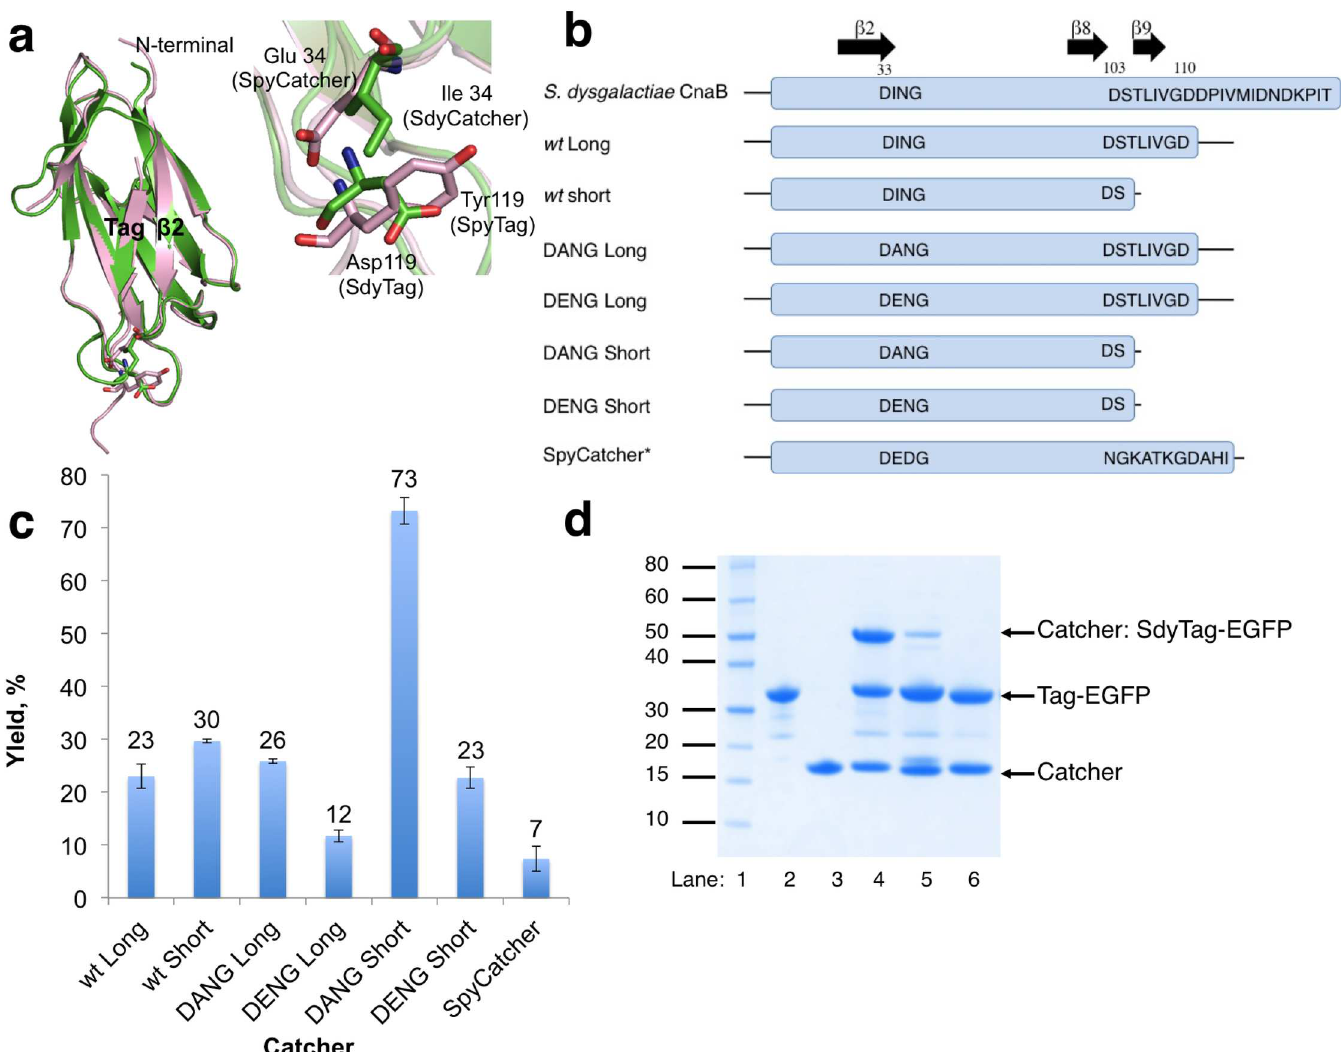
Fig 2. Optimization of S . dysgalactiae Catcher. (a) Alignment of I-TASSER homologymodel of S . dysgalactiae CnaB domain (green) and SpyTag- SpyCatcher complex (pink, 4MLI [24]). Depiction of structure was performed using PyMOL [25]. Inset depicts residues at position 119 (Tag) and 34 (Catcher) for SpyCatcher-SpyTag (pink) and SdyCatcher-SdyTag (green). (b) Schematic diagramof the Catcher variants. Amino acid sequences of the constructs can be found in S1 Table. Residueand beta sheet numbering as follows from Fig 1B. * SpyCatcher sequenceas follows from Zakeri et al [10]. (c) Yield (%) of Catcher: SdyTag-EGFP product, with respect to the limiting Catcher substrate, from in vitro reaction of Catcher with 1.3 equivalent SdyTag- EGFP for 40 minutes at 25˚C, pH 7. Averages of triplicate measurements are shown and their standard deviations are represented by error bars. Yield % are labelled. (d) Covalent ligation of SdyTag-EGFP with Catchers for 80 minutes at 25˚C, pH 7. Lane 1: Novex Sharp ladder (Thermo Fisher Scientific), lane 2: SdyTag-EGFP alone, lane 3: SdyCatcher DANG short alone, lane 4: SdyTag-EGFP incubatedwith SdyCatcher DANG short , lane 5: SdyTag-EGFP incubatedwith SpyCatcher, lane 6: SdyTag(Asp117Ala)-EGFP incubatedwith SdyCatcher DANG short